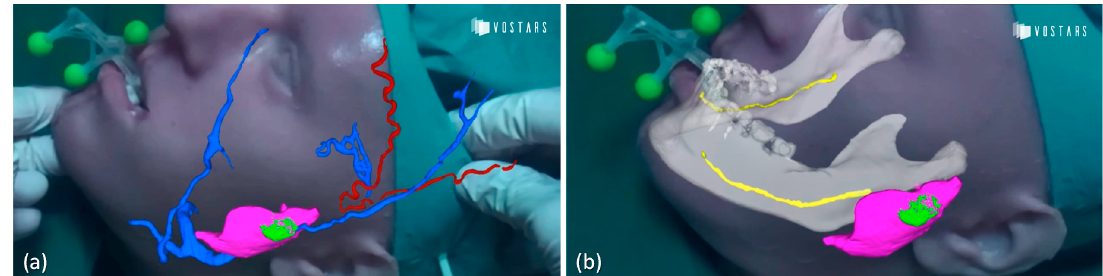
Figure 8. Anatomical augmentation obtained with VOSTARS device displaying vessels with parotid gland and tumor ( a ) and also nerve ( b ). (red: arteries; blue: veins; yellow: nerve; pink: parotid gland; green: tumor mass).